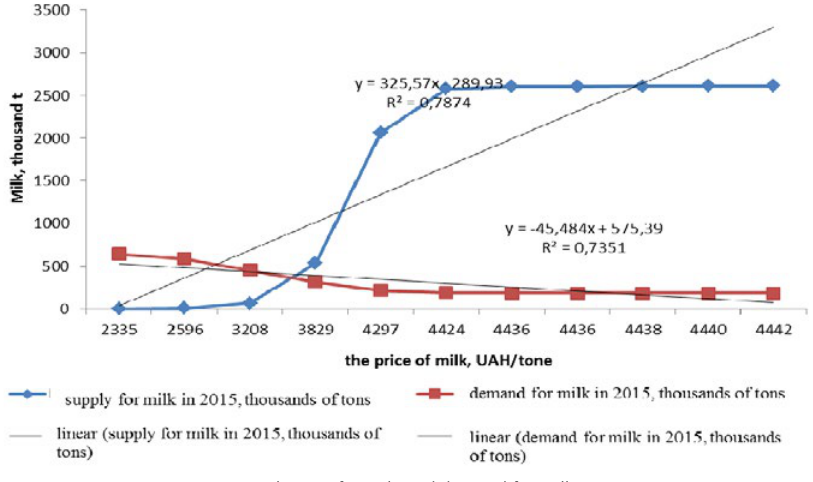
Fig. 1: Correlation of supply and demand for milk in 2015